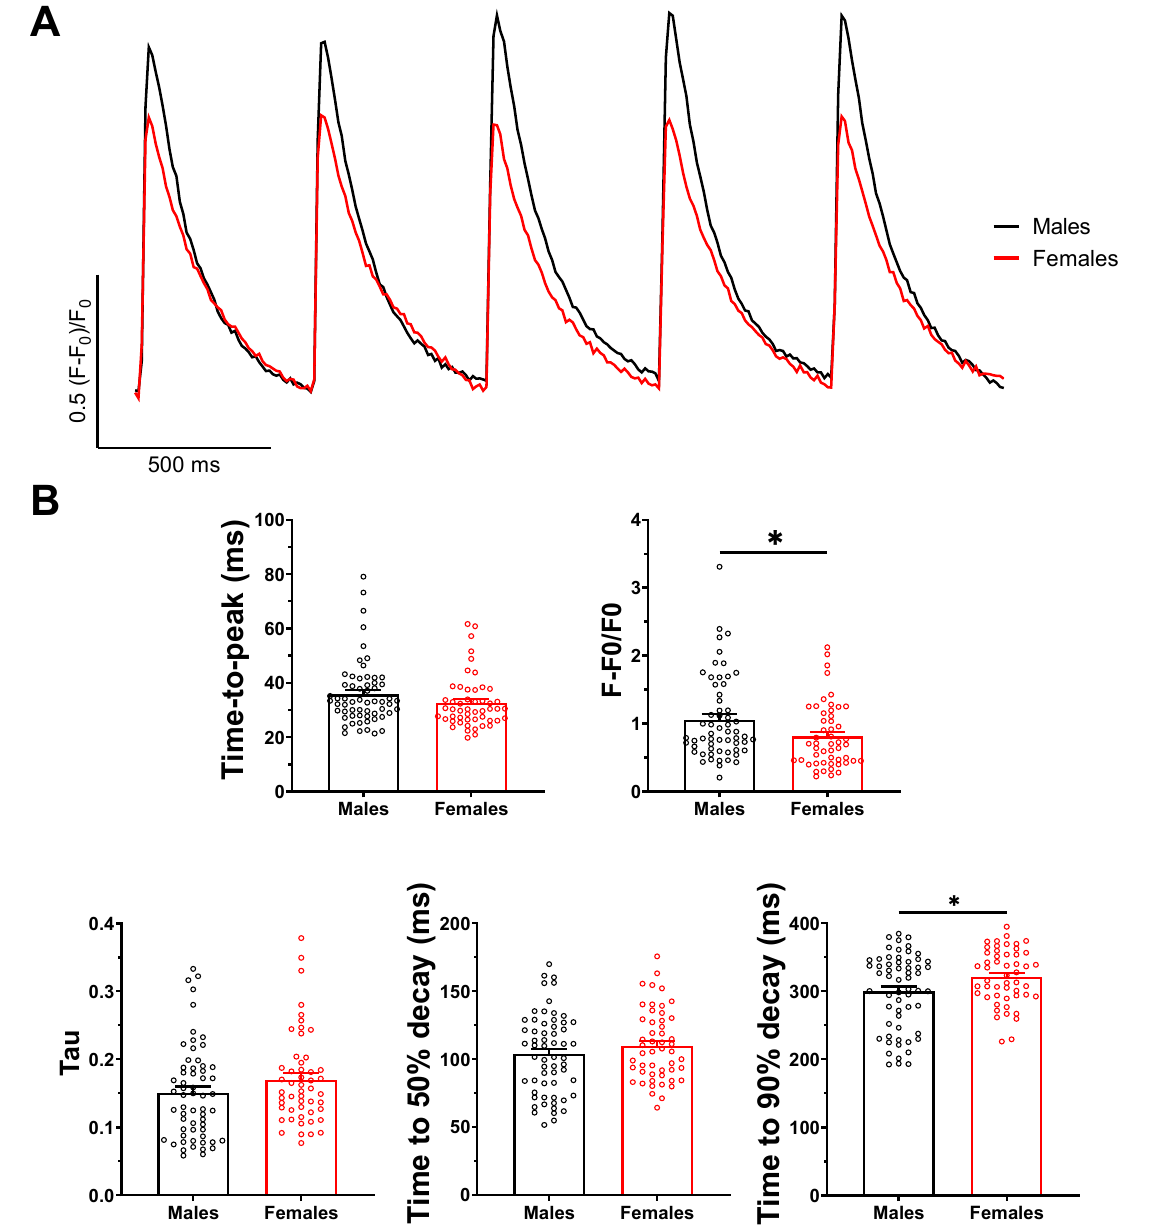
Figure 2. Ca 2+ transients from male atrial myocytes have greater amplitude and faster decay than females. ( A ) Typical Ca 2+ transients of male (black) and female (red) atrial myocytes, under 2 Hz field stimulation, generated using Fluo-4-AM Ca 2+ -sensitive dye in confocal microscopy. ( B ) Ca 2+ transients of male myocytes have a greater amplitude (F-F 0 /F 0 ) than female (M: 1.06 ± 0.08; F: 0.81 ± 0.07; * p = 0.02). Time-to-peak, tau of decay, and time to 50% decay were not statistically different between sexes. Time to 90% decay was faster in males (M: 300 ± 7 ms; F: 321 ± 6 ms; * p = 0.02) (for each parameter: M: n = 59–60, N = 3; F: n = 50–51, N = 3). * p < 0.05